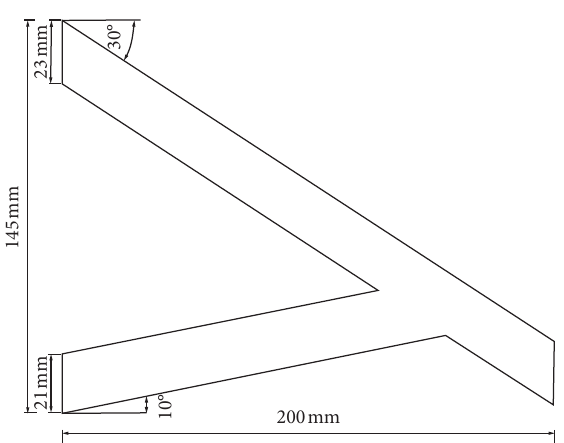
Figure 4: Sketch of diamond back wing.